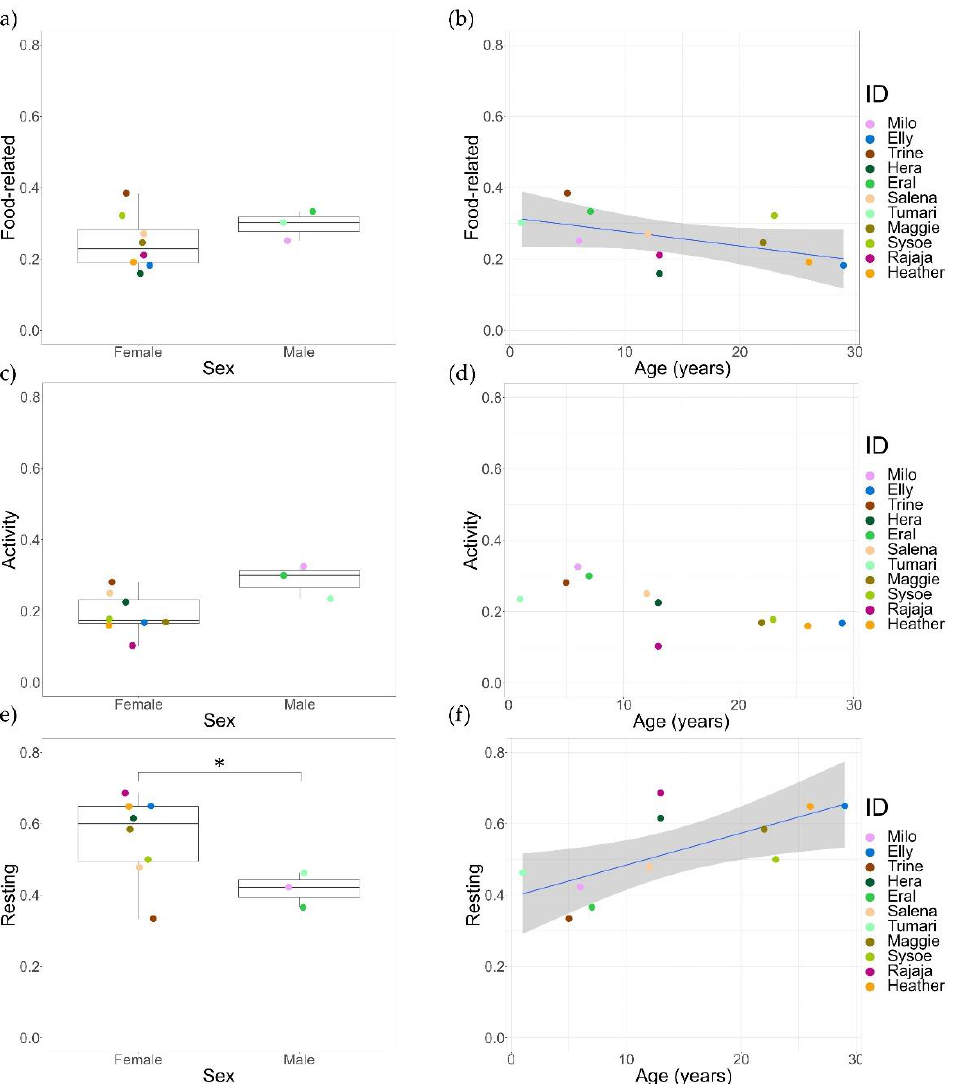
Figure 6. An overview of time spent on specific behavioural states (in percentages) and their relation to age and sex. Solid lines are trendlines, and 95% confidence intervals are given. ( a ) No difference was found in time spent on food-related behaviour between males and females. ( b ) Age is negatively correlated with time spent on food-related behaviours. ( c ) No difference was found between activity levels of females and males. ( d ) No correlation could be found between age and activity. ( e ) Females spent more time resting compared to males, significance indicated with *. ( f ) Age is positively correlated with resting time.